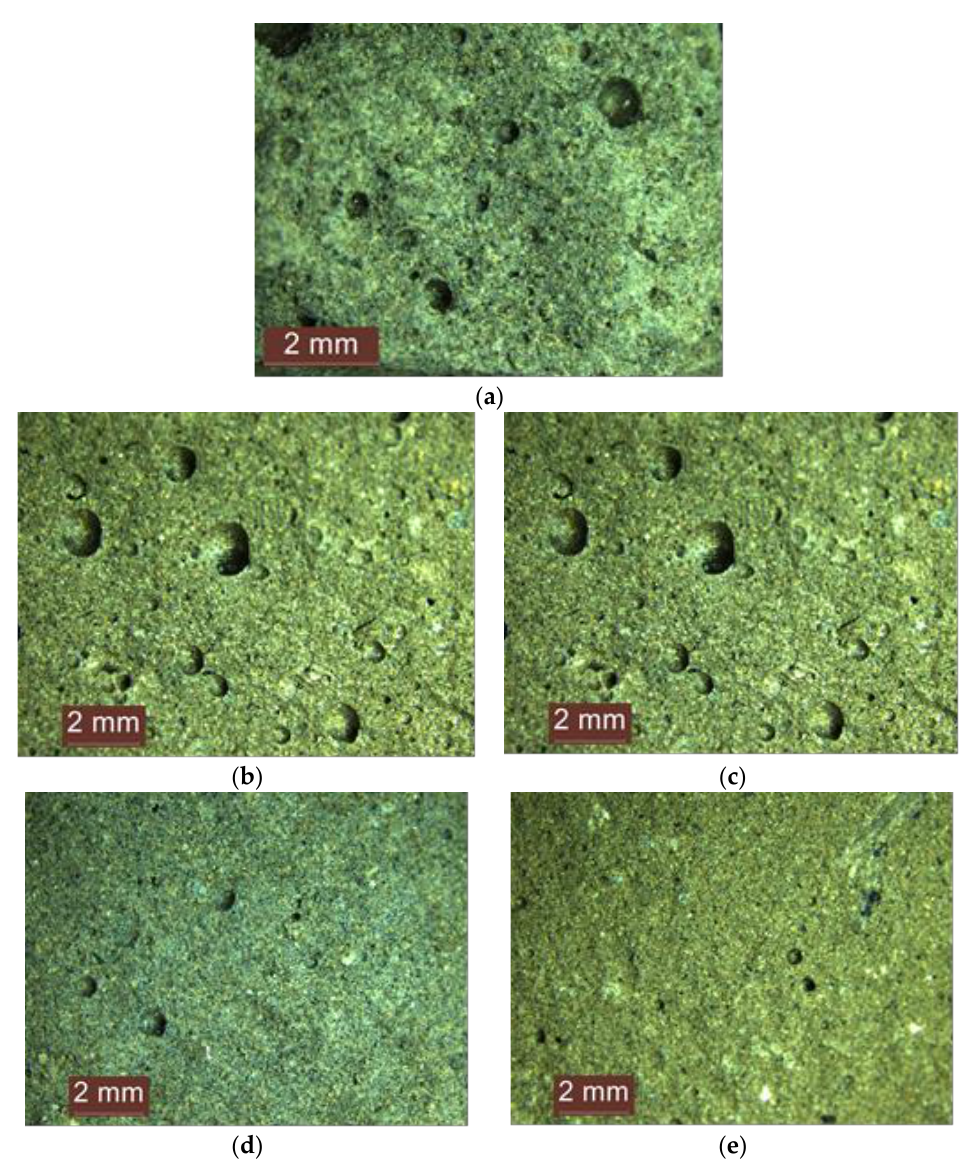
Figure 9. Microscopic images of geopolymer pastes with different substitutions, made at 1× magnification for mixtures: ( a ) C; ( b ) P1; ( c ) P7; ( d ) P6 and ( e ) P12.